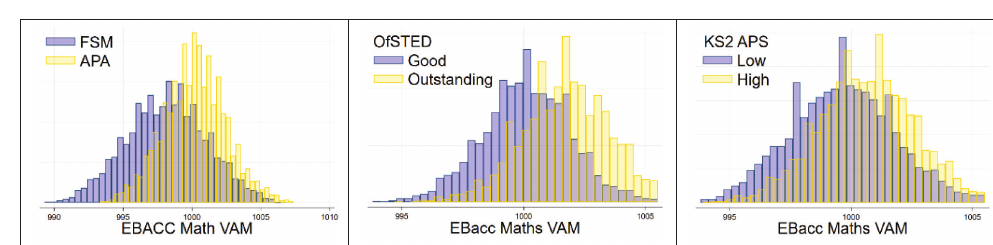
Figure 2: Gap between FSM and APA, Ofsted Good and Outstanding schools, and low and high KS2 APS (Source: SWC, 2010–14, and matched Ofsted